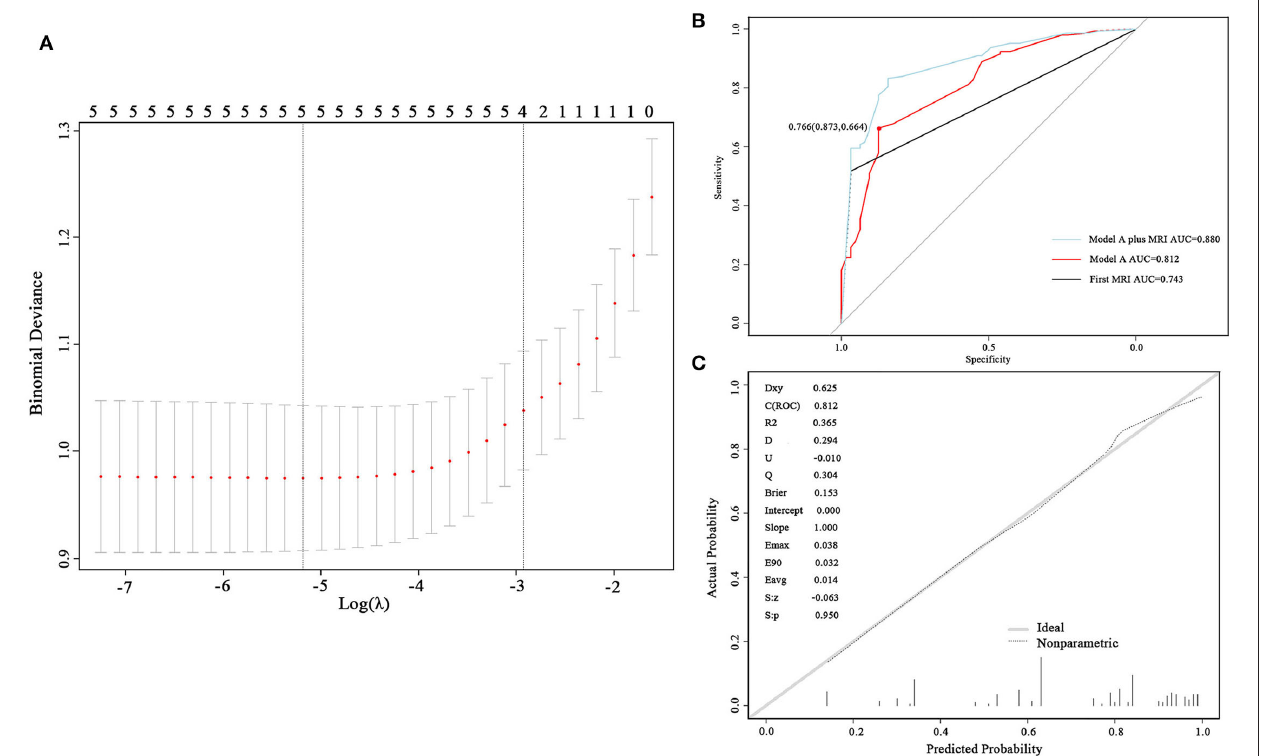
FIGURE 2 | Development and validation of model A. (A) Cross-validation plot for the penalty term. Two solid lines corresponded to five and four variables when λ was minimum and minimum within one SE, respectively. (B) ROC curves of model A and the first magnetic resonance imaging (MRI). The AUC was 0.812 for model A and 0.743 for the first MRI. (C) The calibrated curve of model A. The gray solid line represents the actual probability, and the dotted line represents the prediction probability of model A. AUC, area under the curve; ROC, receiver operating characteristic.